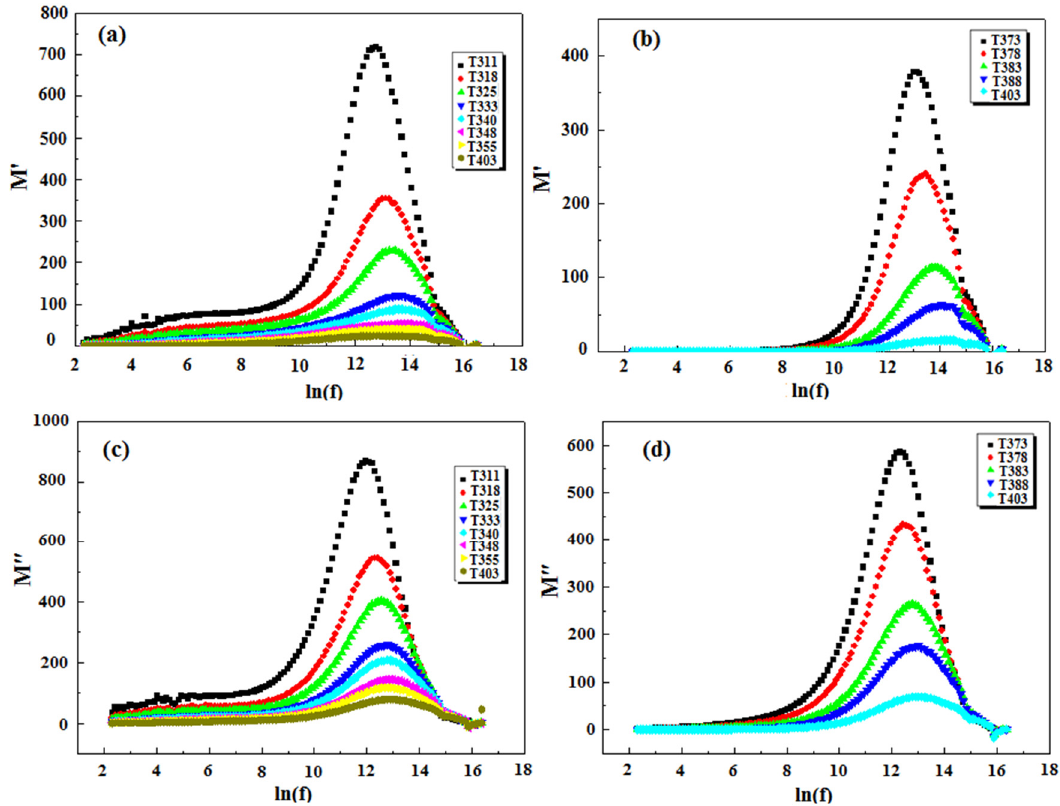
Figure 16. ( a , b ) Variation of M (cid:48) (real part of the electrical modulus) versus ln(f) of (C 5 H 14 N 2 )[HgCl 4 ] · H 2 O at various temperatures; ( c , d ) variation of M (cid:48)(cid:48) (imaginary part of the electrical modulus) versus ln(f) of (C 5 H 14 N 2 )[HgCl 4 ] · H 2 O at various